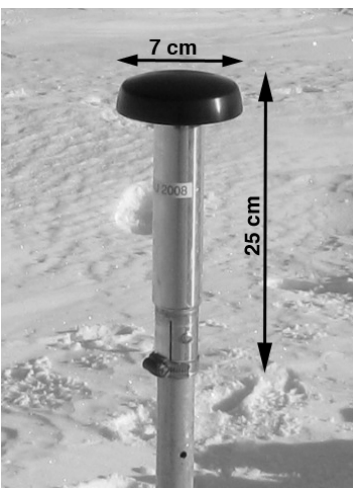
Fig. 1. GPS unit attached to a mass-balance